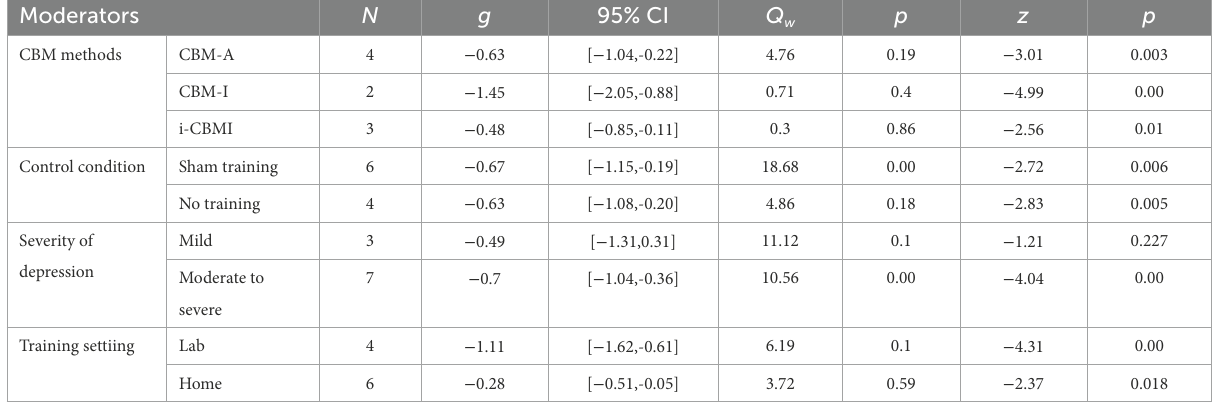
TABLE 3 Subgroup analysis with categorical variables for depression symptoms at